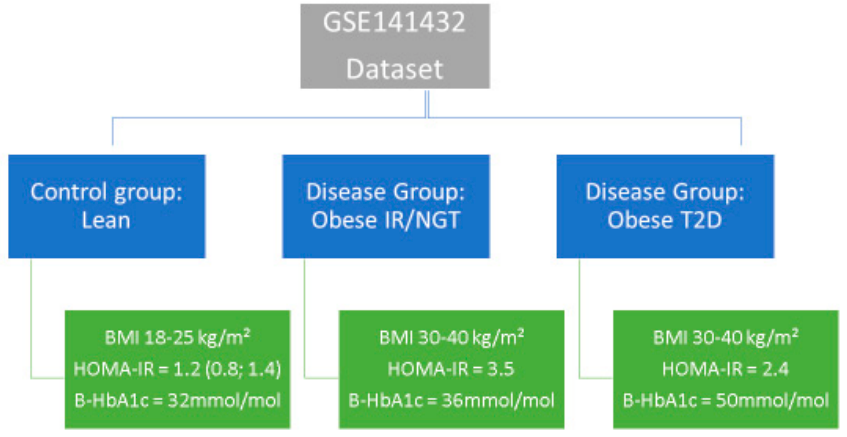
Figure 9. Dataset baseline information.